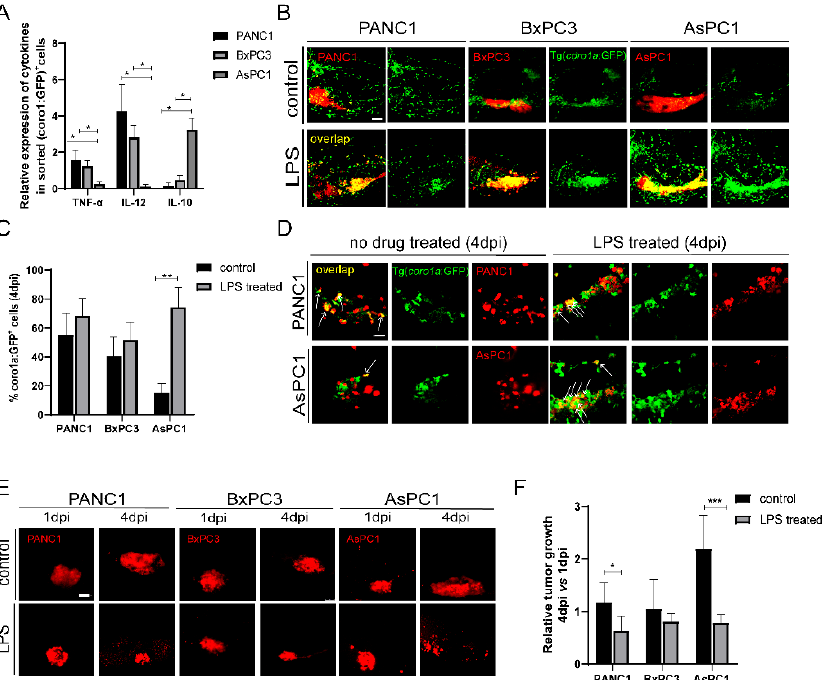
Figure 3. PANC1, BxPC3, and AsPC1 cells induce anti-tumoral or pro-tumoral state of innate immune cells. ( A ) The relative expression of TNF- α , IL-12, and IL-10 in coro1a: GFP + cells sorted from PANC1, BxPC3, and AsPC1 xenografts (* p < 0.05, t test). ( B ) Representative confocal images of innate immune cells in PANC1, BxPC3, and AsPC1 xenografts at 4 dpi after treatment with DMSO (control) or LPS (150 µ g/mL). ( C ) Qualification of coro1a: GFP + innate immune cell percentage in PANC1, BxPC3, and AsPC1 cells at 4 dpi under the control and LPS condition (no. of innate immune cells/no. of tumor cells × 100). Results are shown as means ± SEM from nine different individuals (** p < 0.01, t test). ( D ) Enlarged confocal images of innate immune cells co-localized with PANC1 and AsPC1 cells at 4 dpi under the control or LPS treatment. Arrowheads point to the co-localized cells. ( E ) Representative confocal images of PANC1, BxPC3, and AsPC1 xenografts at 1 dpi and 4 dpi with the treatment of DMSO (control) or LPS (150 µ g/mL) respectively. ( F ) Relative tumor growth in xenografts (4 dpi vs. 1 dpi) after being treated with DMSO or LPS. Results are from nine different individuals (* p < 0.05, ** p < 0.01, *** p < 0.001, t test). dpi, days post injection. Scale bars in ( B , E ), 50 µ m; in ( D ), 25 µ m.